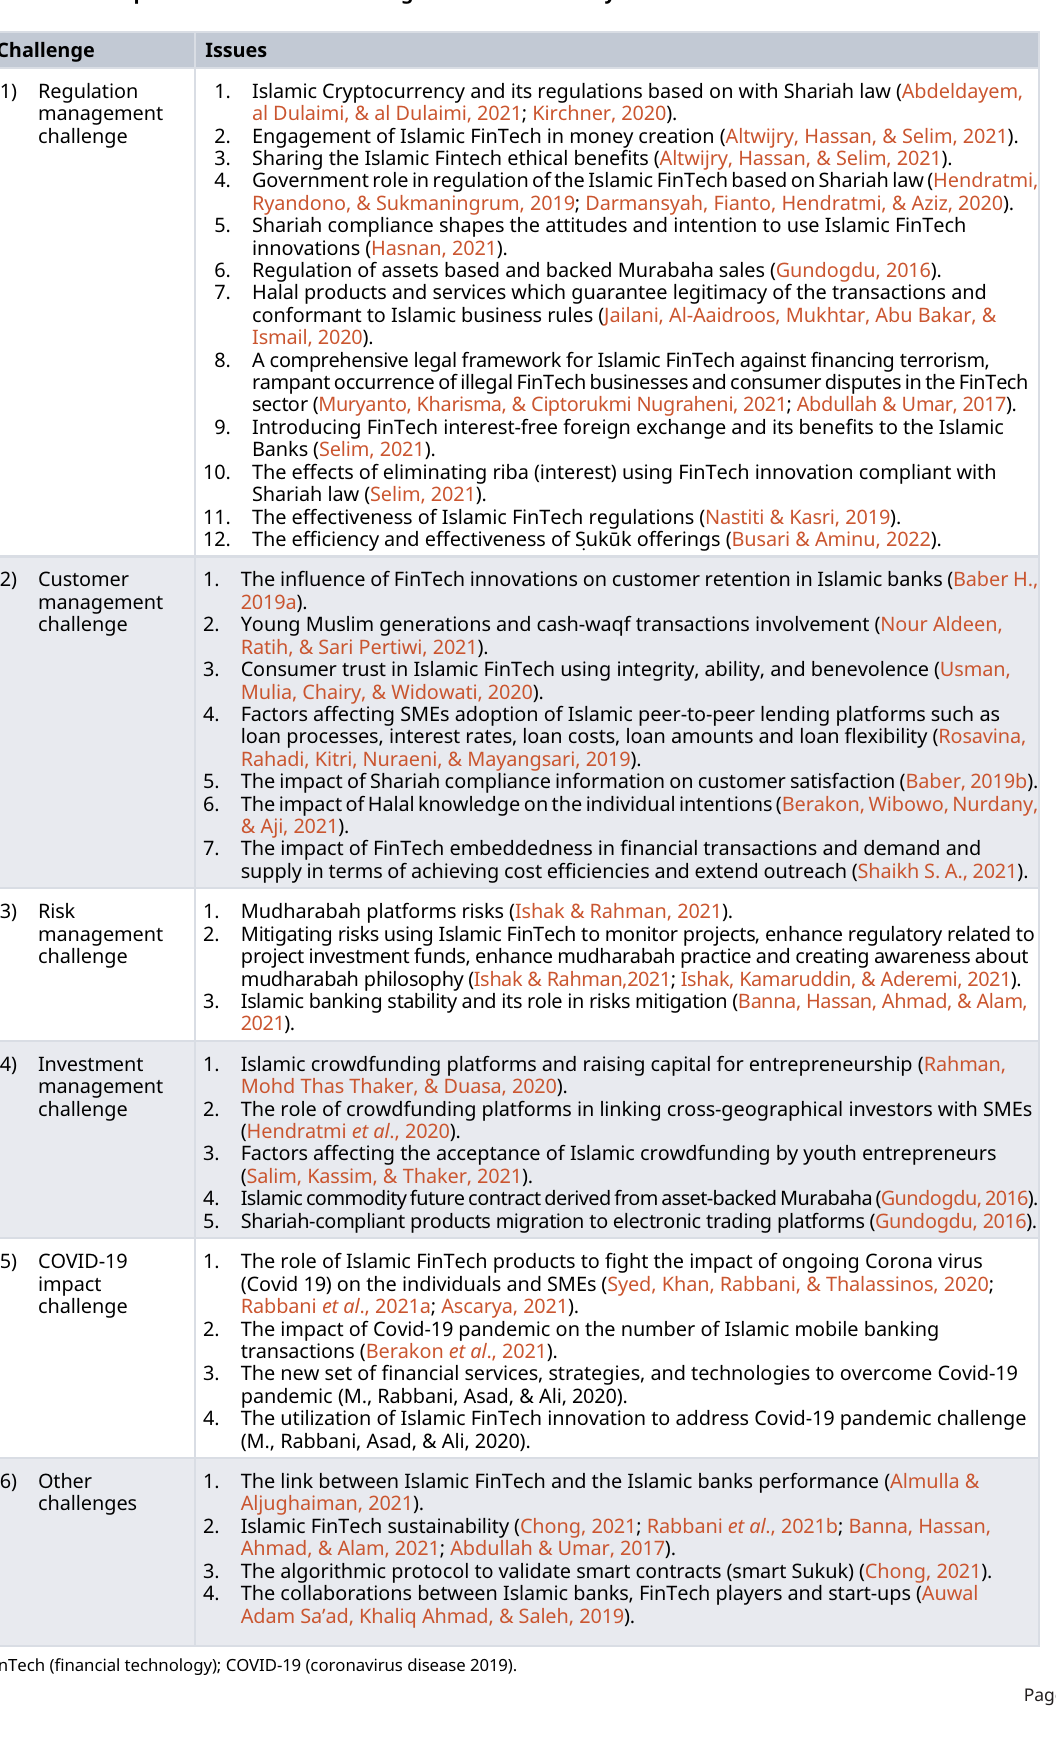
Table 3. Issues per Islamic FinTech challenge found in this